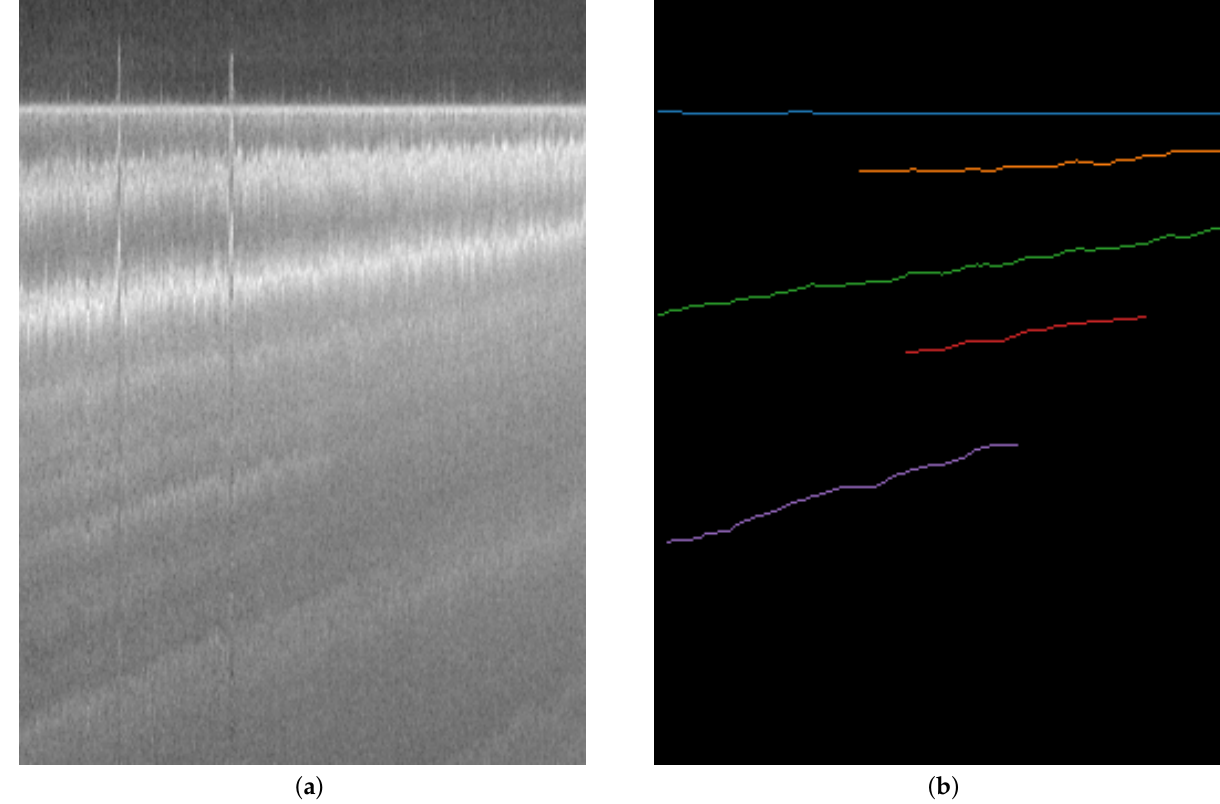
Figure 3. Noisy radar image ( a ) and its labels ( b ). Both are generated through Koenig et al. [5]. The deep layers in the radar image cannot be seen properly, and the labels available for them are